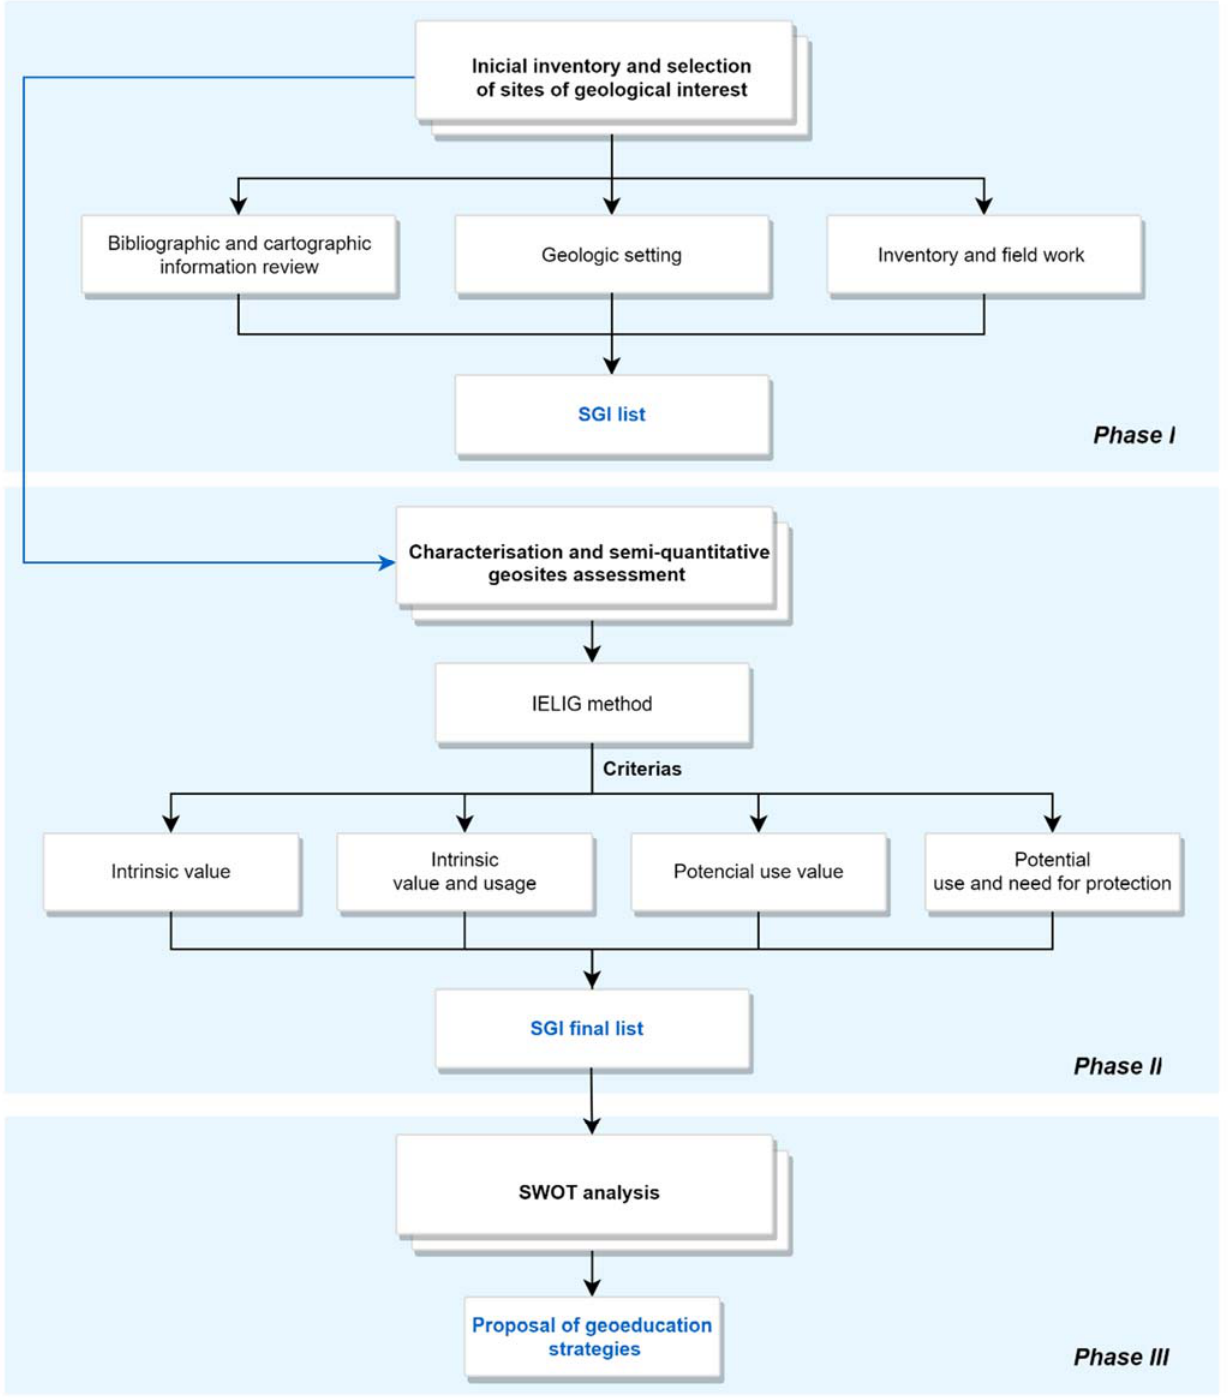
Figure 2. The methodology applied in the present study. SGI: sites of geological interest.